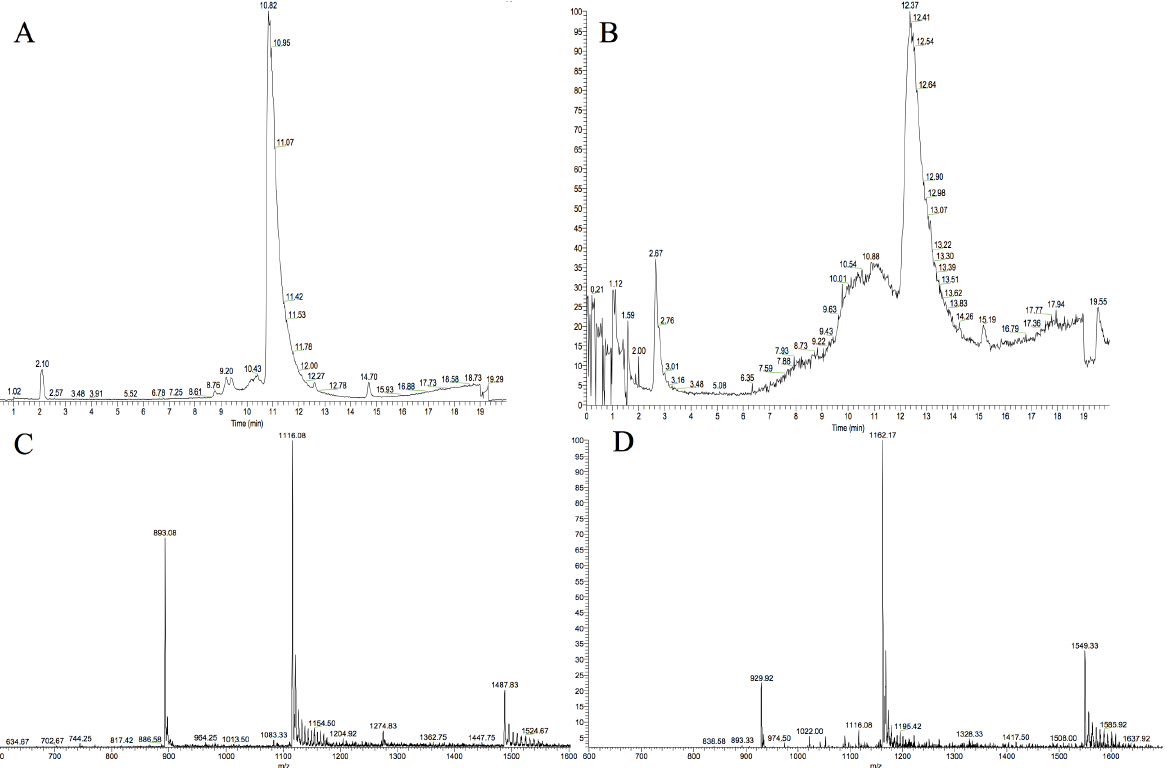
PLOS ONE | DOI:10.1371/journal.pone.0161209 August 17,